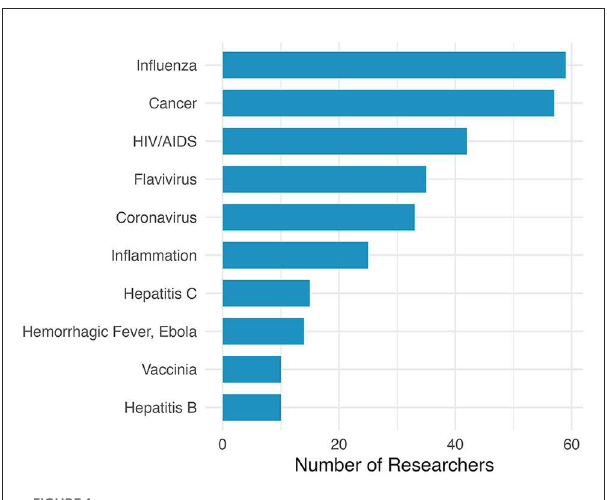
FIGURE2 MeSH conditions most frequently associated with research articles cited by COVID-19 vaccine